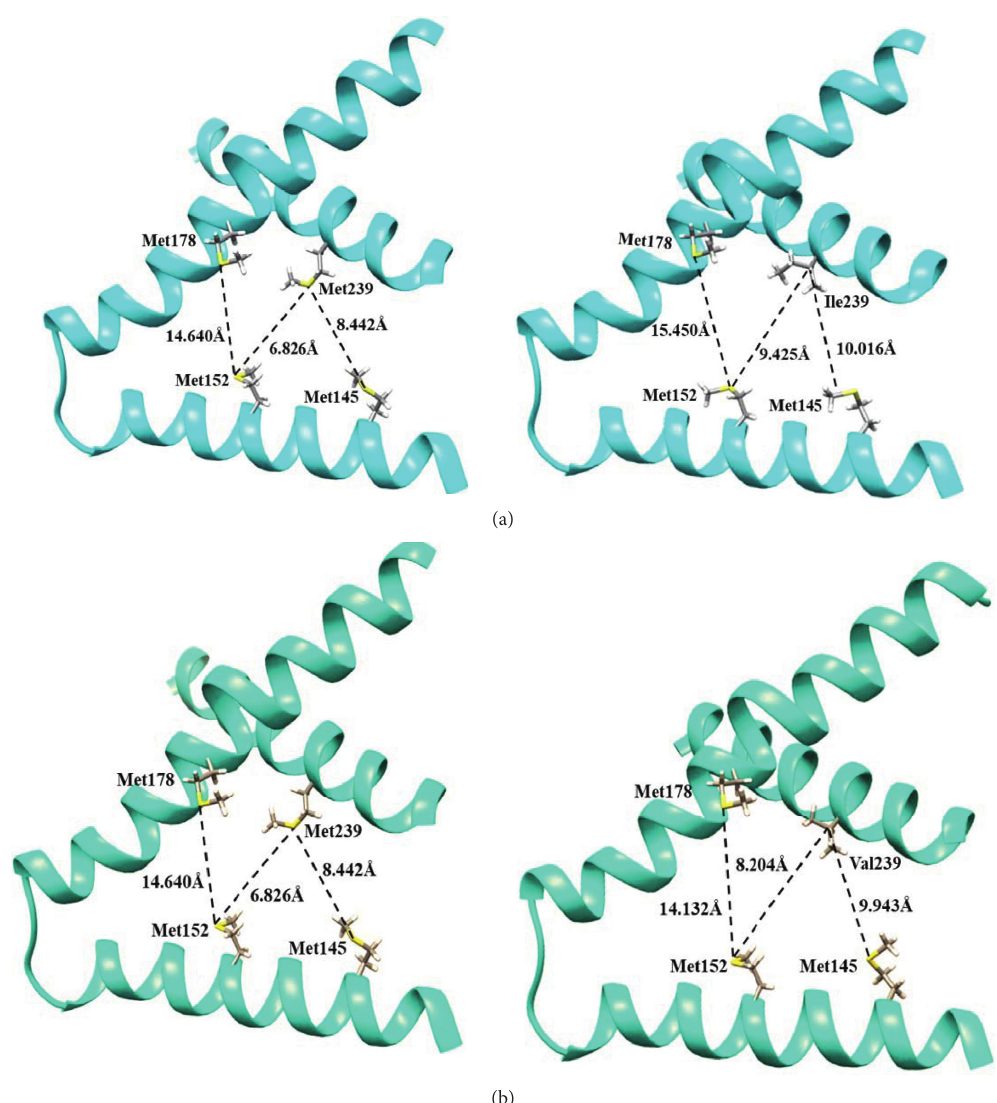
Figure 4: Structural changes in the pore of the PS2 protein by Met239Ile and Met239Val mutations. (a) Ribbon representation of the Met239Ile mutation. (b) Ribbon representation of the Met239Val